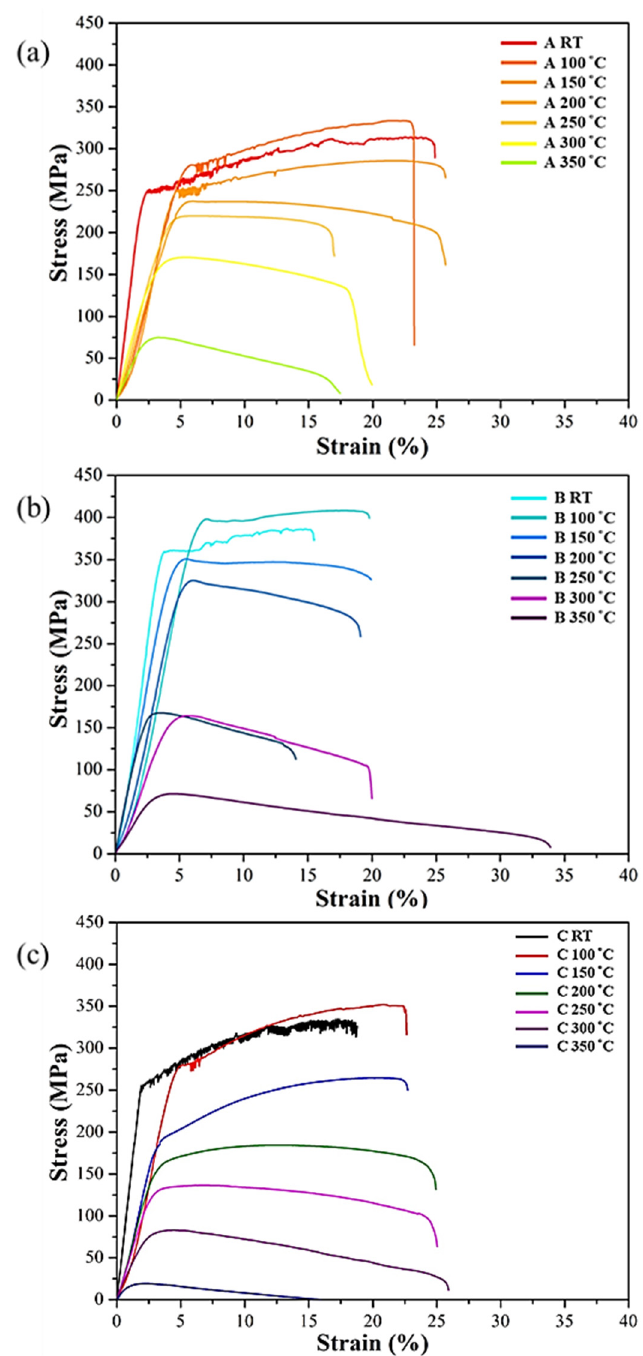
Figure 6. High-temperature tensile stress–strain curve of the SLM Al–Mg–Sc–Zr alloys: ( a ) as-printed and ( b ) single-stage- and ( c ) two-stage-heat-treated specimens.